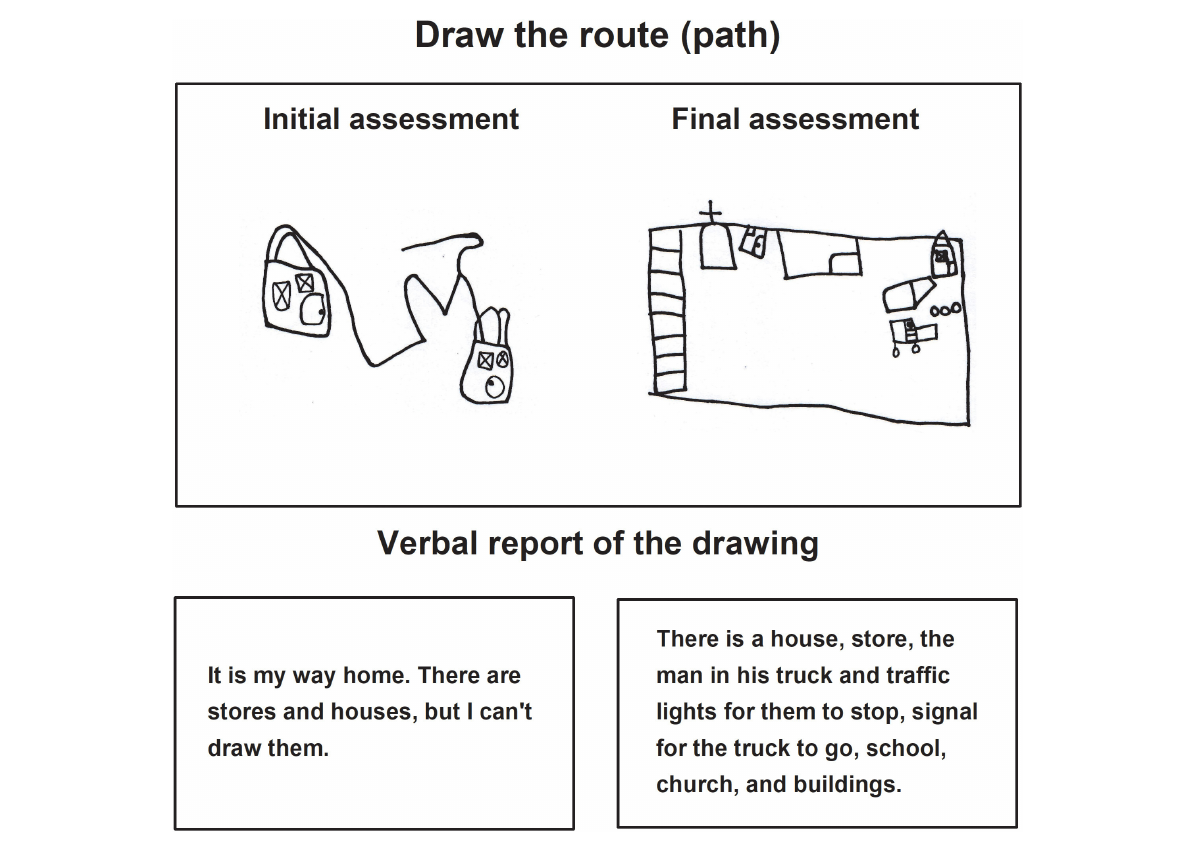
FIGURE8 Child H drawing of places in the city during the initial and final